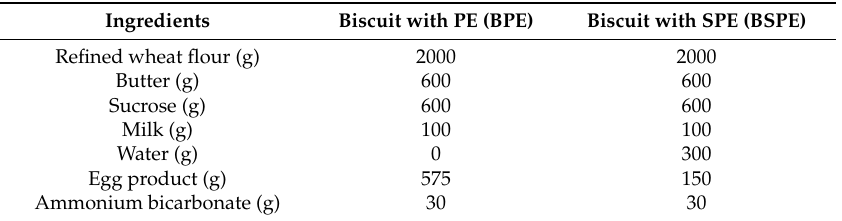
PE, pasteurized eggs; SPE, spray dried pasteurized